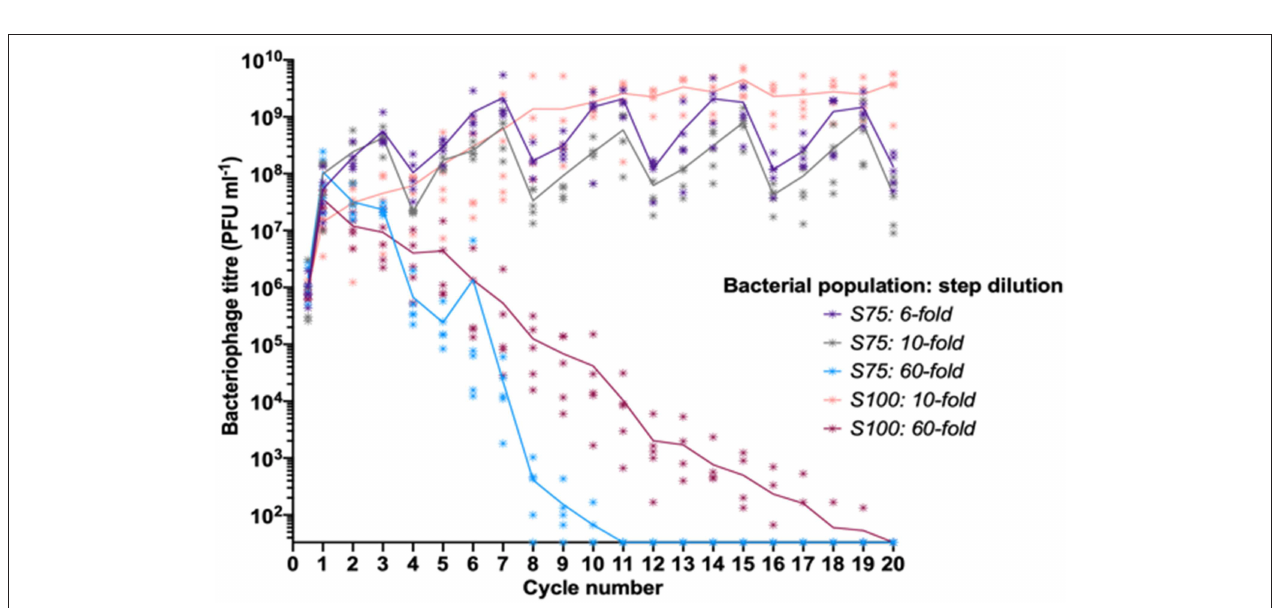
FIGURE 3 | Linear oscillating prey assay for phage HP1c1 infections of H. influenzae strain Rd populations with varying dilution constants between each cycle. Each line indicates the mean phage titer during cycling of phage HP1c1 through either the S75 or S100 population patterns when different dilutions are applied between each cycle. The population structures are indicated in the legend (i.e., S100, all S; S75, S-S-S-R), as are the dilution constants applied between each cycle. Both the S75: 10-fold and the S100: 10-fold populations are those also found in Figure 2 . The phage HP1c1 titer was determined at the end of each cycle. Points represent the phage titer observed from each of five biological replicates, with the line showing the mean of these replicates.